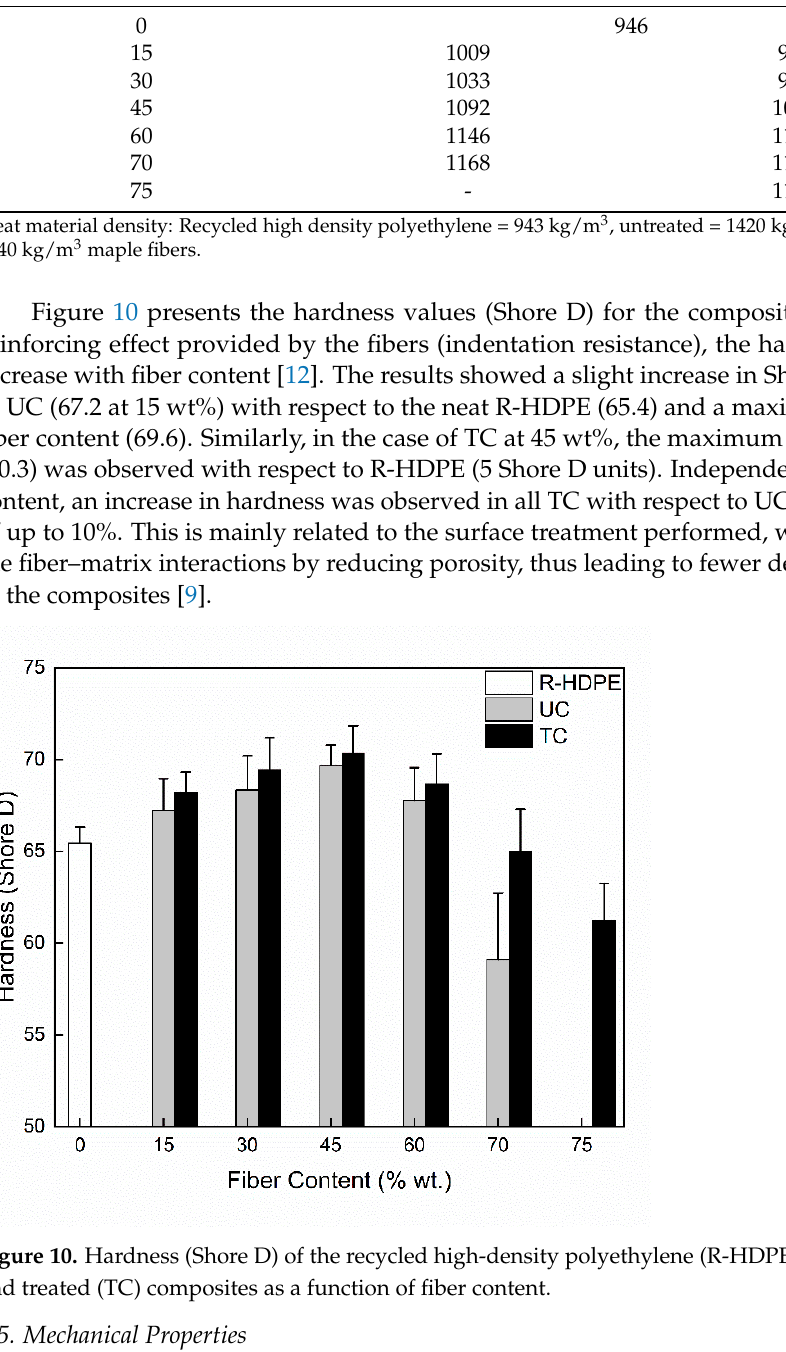
Table 1. Density of the samples produced (+/ − 1 kg/m 3 ).